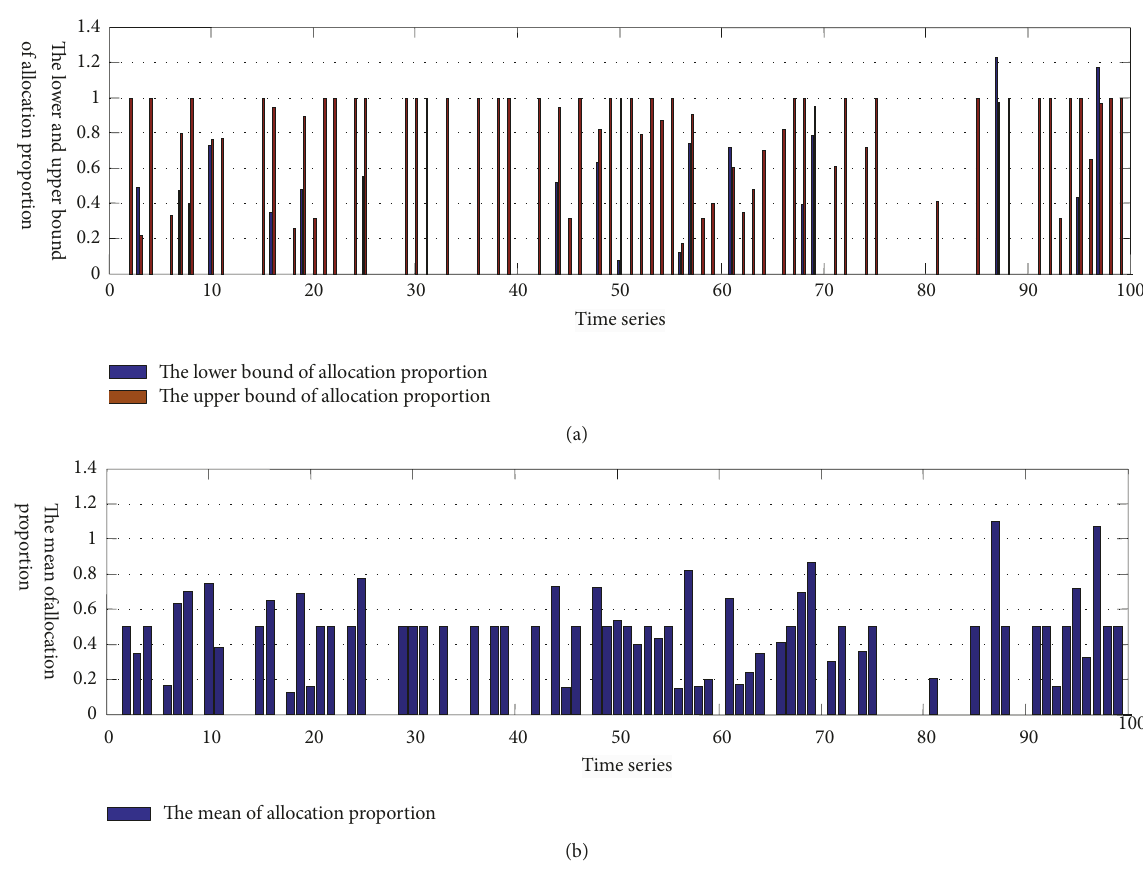
Figure 7: Allocation